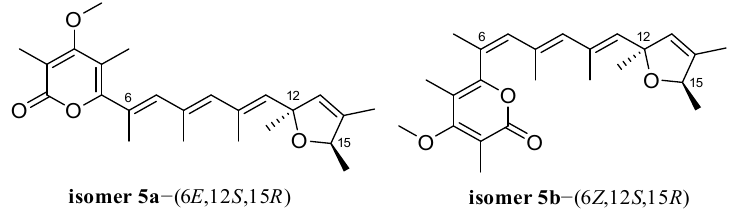
Figure 9. Two possible isomers of compound 5 for DP4+ probability analysis. Poloncosidin F ( 6 ) was obtained as a colorless oil with a molecular formula of C 23 H 32 O 6 as determined by the HRESIMS data. Its 1 H- and 13 C-NMR data (Tables 1 and 2)